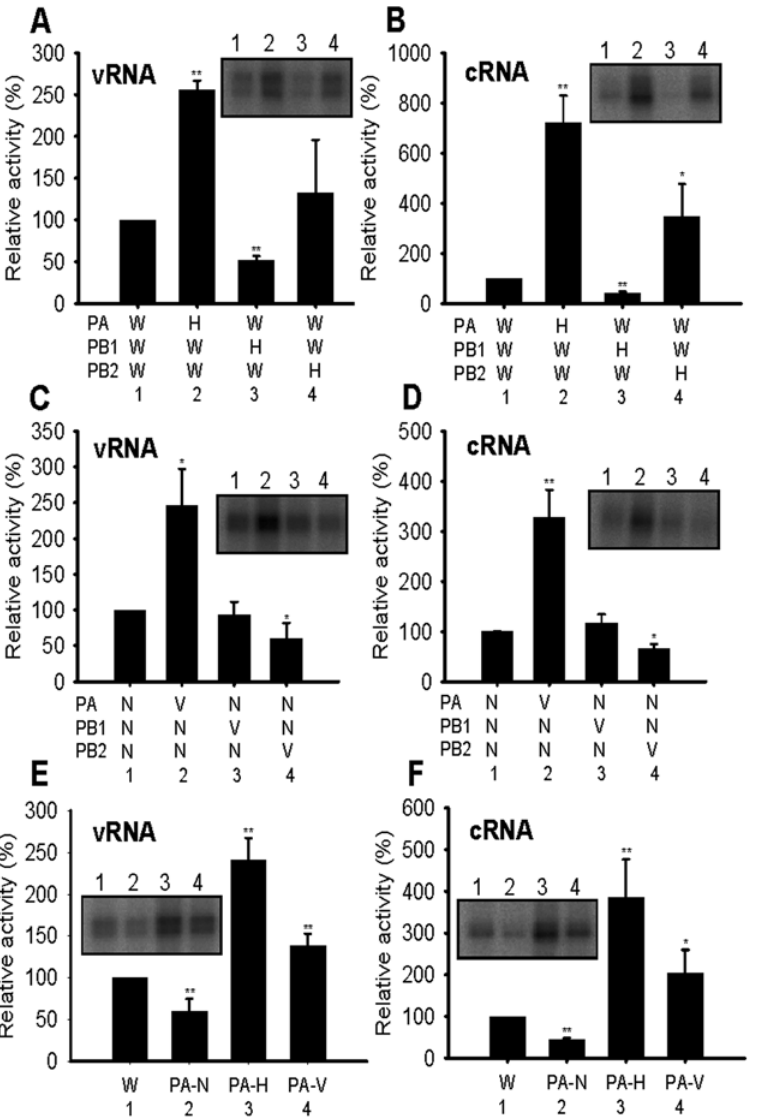
Figure 3. UV cross-linking of model vRNA and cRNA promoters to hybrid polymerases. Purified and quantified polymerases were incubated, in (A), (C) and (E), with 32 P-labelled 3 9 strand of the vRNA promoter in the presence of the unlabelled 5 9 strand of the vRNA promoter, or in (B), (D) and (F), with 32 P -labelled 3 9 strand of the cRNA promoter in the presence of the unlabelled 5 9 strand of the cRNA promoter. (A), (B) Hybrids between HK (H) and WSN (W), as indicated. (C), (D) Hybrids between VN (V) and NT (N), as indicated. (E), (F) WSN (W) polymerase was compared to hybrid polymerases of the PA of NT (PA-N), HK (PA-H) or VN PA (PA-V) with PB1 and PB2 from WSN. Relative activity is % relative to WSN from at least 3 independent experiments. Inset square panels show typical gels. * and ** indicate statistically significant differences (from W or N) at p , 0.05 and p , 0.01, respectively, in a Student’s t-test.